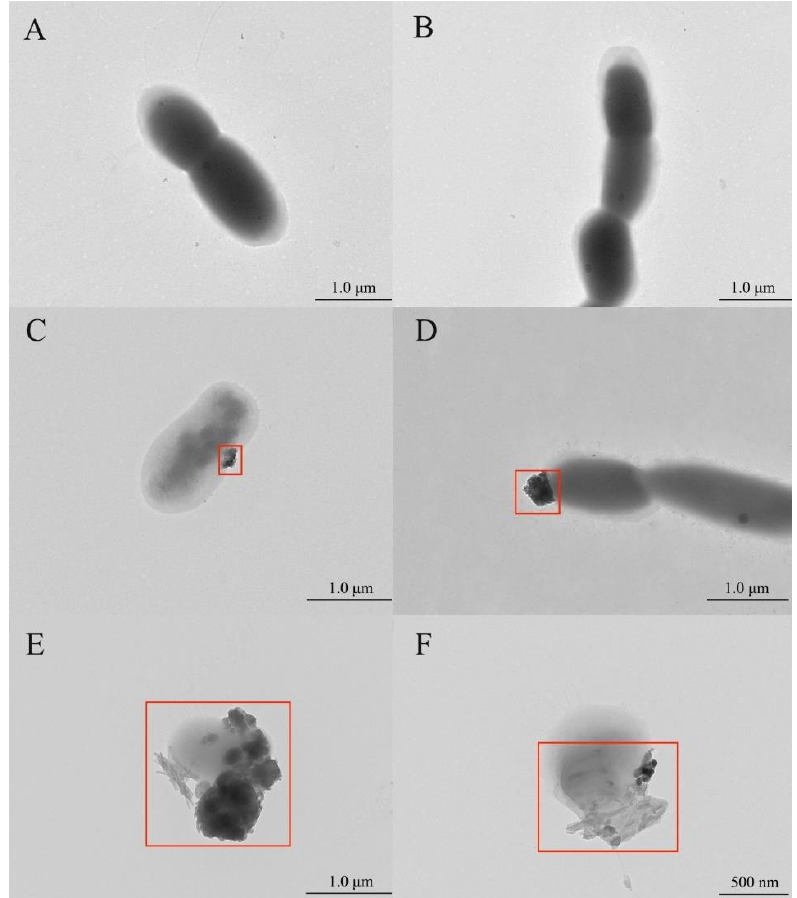
Figure 4. Morphology of strain CW126-A03 cells. ( A , B ), cells morphology cultured in growth medium; ( C , D ), cells morphology on the 1st day of interaction experiments; ( E , F ), cells morphology on the 4th day of interaction experiments.